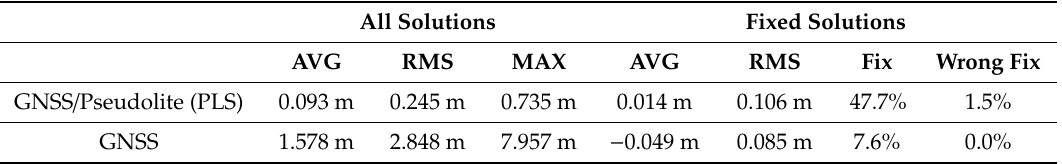
Table 5. Results of the height of the GNSS / pseudolite PPP based on observation data. All